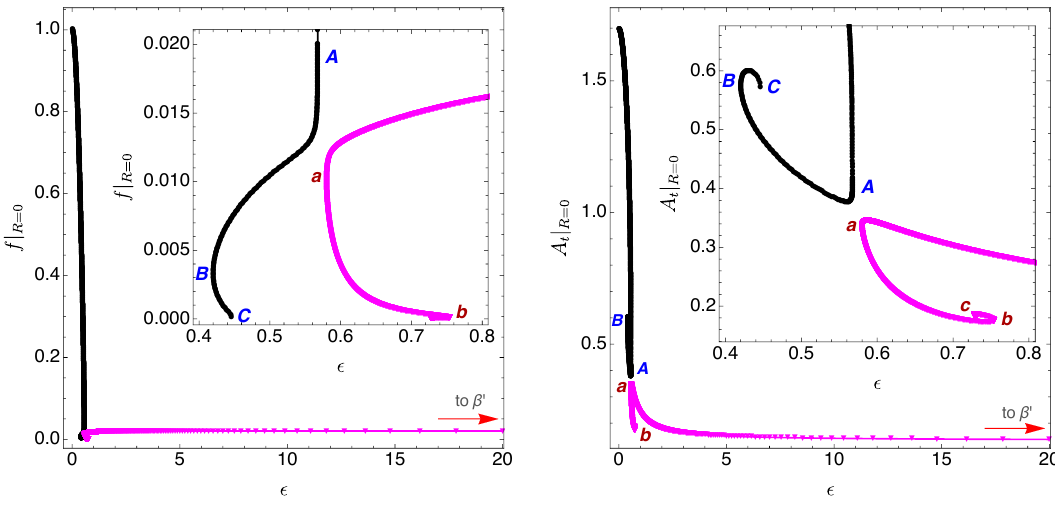
Figure 7 . Soliton families with e = 1 . 854 ( e γ < e < e c ). As in previous plots, the black curve represents the main family and the magenta line represents the secondary family. In both figures, the inset plots zooms in around the region where the two soliton families approach the most. As e → e − , the gap between A and a decreases until these two points merge precisely at e = e c . Left c panel: the function f evaluated at the origin of the soliton is plotted as a function of the amplitude (cid:15) . The two families seem to be on top of each other for a small range of (cid:15) but the inset plot shows that this is not the case and a small gap is still present while e 6 = e c . Right panel: the gauge field A t evaluated at the origin as a function of (cid:15) . Both families spiral inward towards a singularity in one of their endpoints: this corresponds to the cusp structure observed in the Q − ∆ M